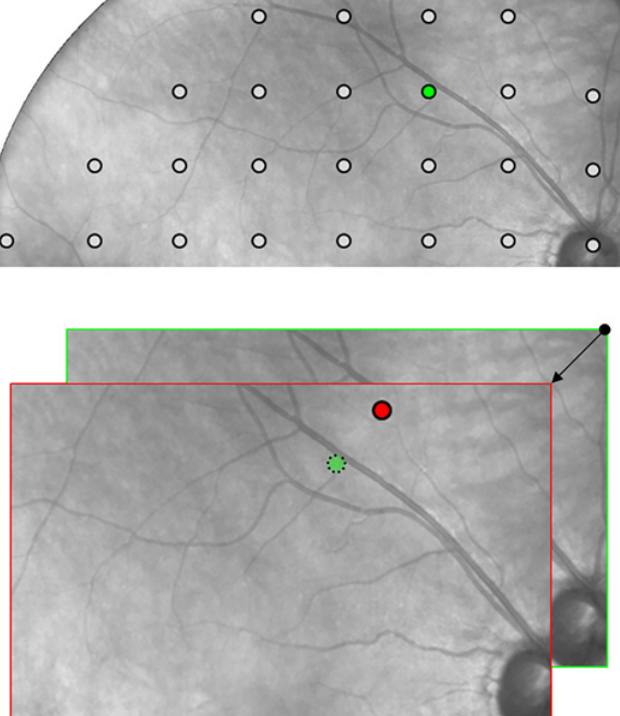
Fig 2. Eye tracking compensation. (A) The green dot shows the expected presentation position on the retina of one of the 24 – 2 measurement locations. (B) The red dot shows the actual presentation position in presence of a 3-degree eye movement at the time of presentation (see arrow) and in absence of a compensation mechanism: the red dot is where the HFA would actually measure sensitivity, without a chance to time-correlate presentation of this stimulus with the information provided by the gaze tracker. The use of a 25 Hz retinal tracker instead, enables Compass to maintain the expected presentation position even in presence of wide and fast eye